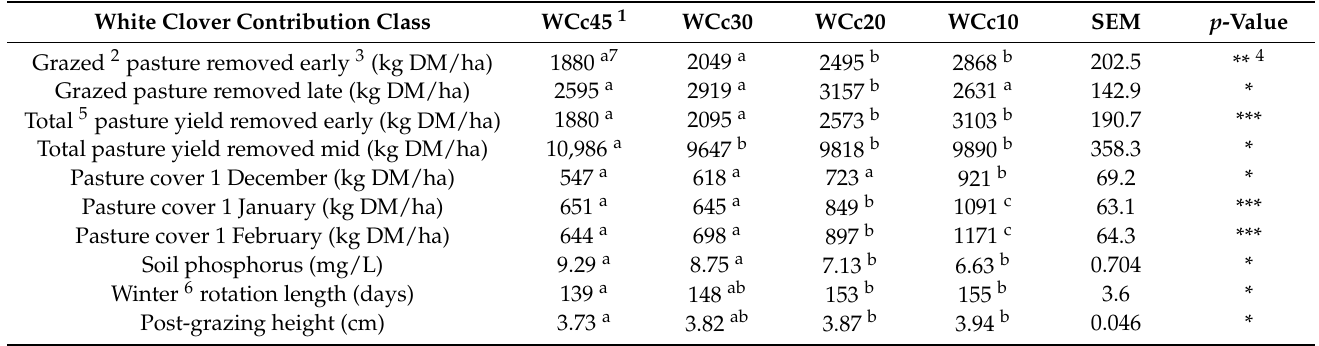
Table 2. Comparison of paddocks in different white clover contribution (WCc) classes for pas- ture growth, soil phosphorus and grazing variables (only variables with significant differences ( p < 0.05)